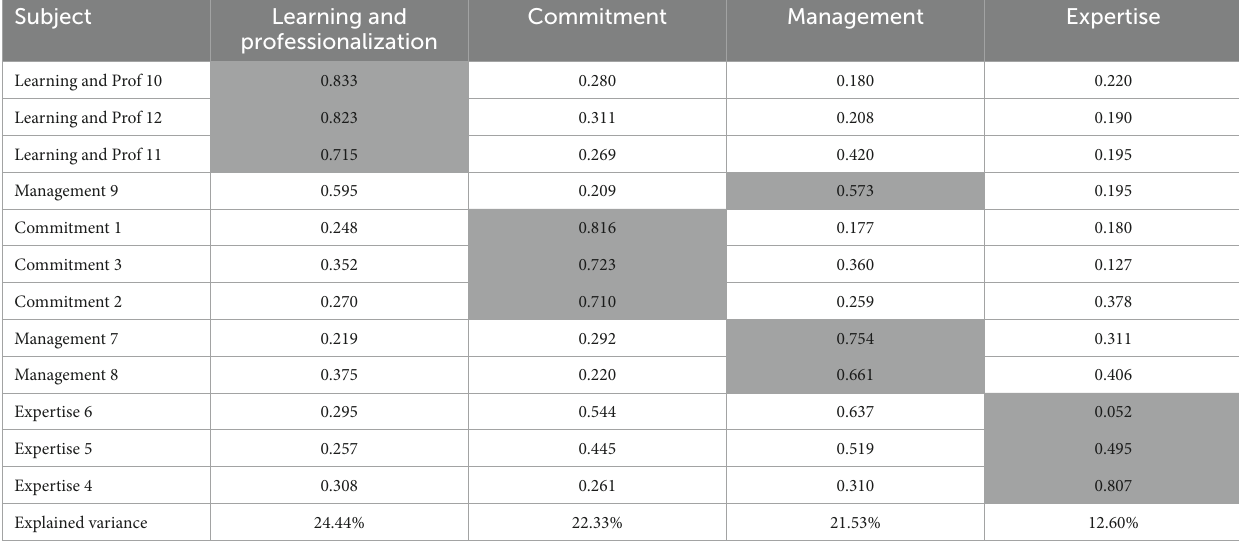
TABLE 4 Analysis of factors and loadings of assessment